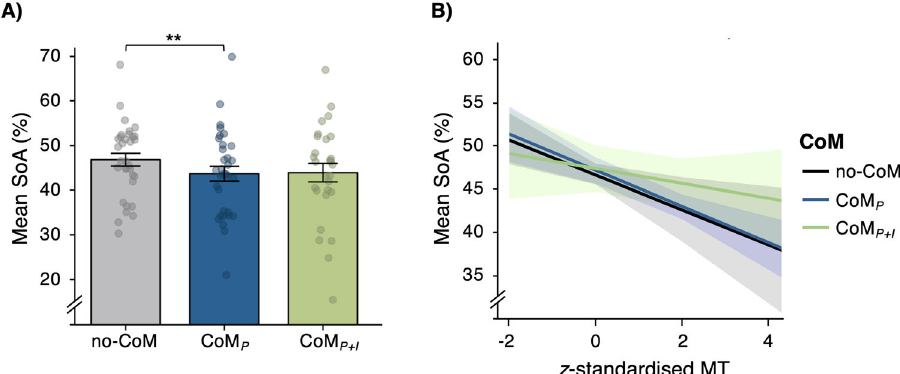
Fig. 4 Effect of Changes of Mind (CoM) on Sense of Agency (SoA) ratings in Exp. 1 and 2 ( n = 33 participants). A Mean SoA ratings for each type of CoM (grey = no CoM; blue = perceptual CoM; green = perceptual + intentional CoM) in test trials. In both ( A ) and ( B ), data are presented as mean values ± 1 SEM. Dots represent data points from individual participants. Post hoc tests in a linear mixed-effects regression model revealed that SoA ratings were lower in CoM P than no-CoM trials (** p < 0.001; Bonferroni-corrected α -level of 0.05/3 = 0.017). B) Predicted SoA ratings (marginal effects) for a mixed-effects model with CoM (no-CoM/CoM P /CoM P + I ) and movement times (MT) as predictors, based on collapsed data from Exp. 1 and 2 (M ± 95%